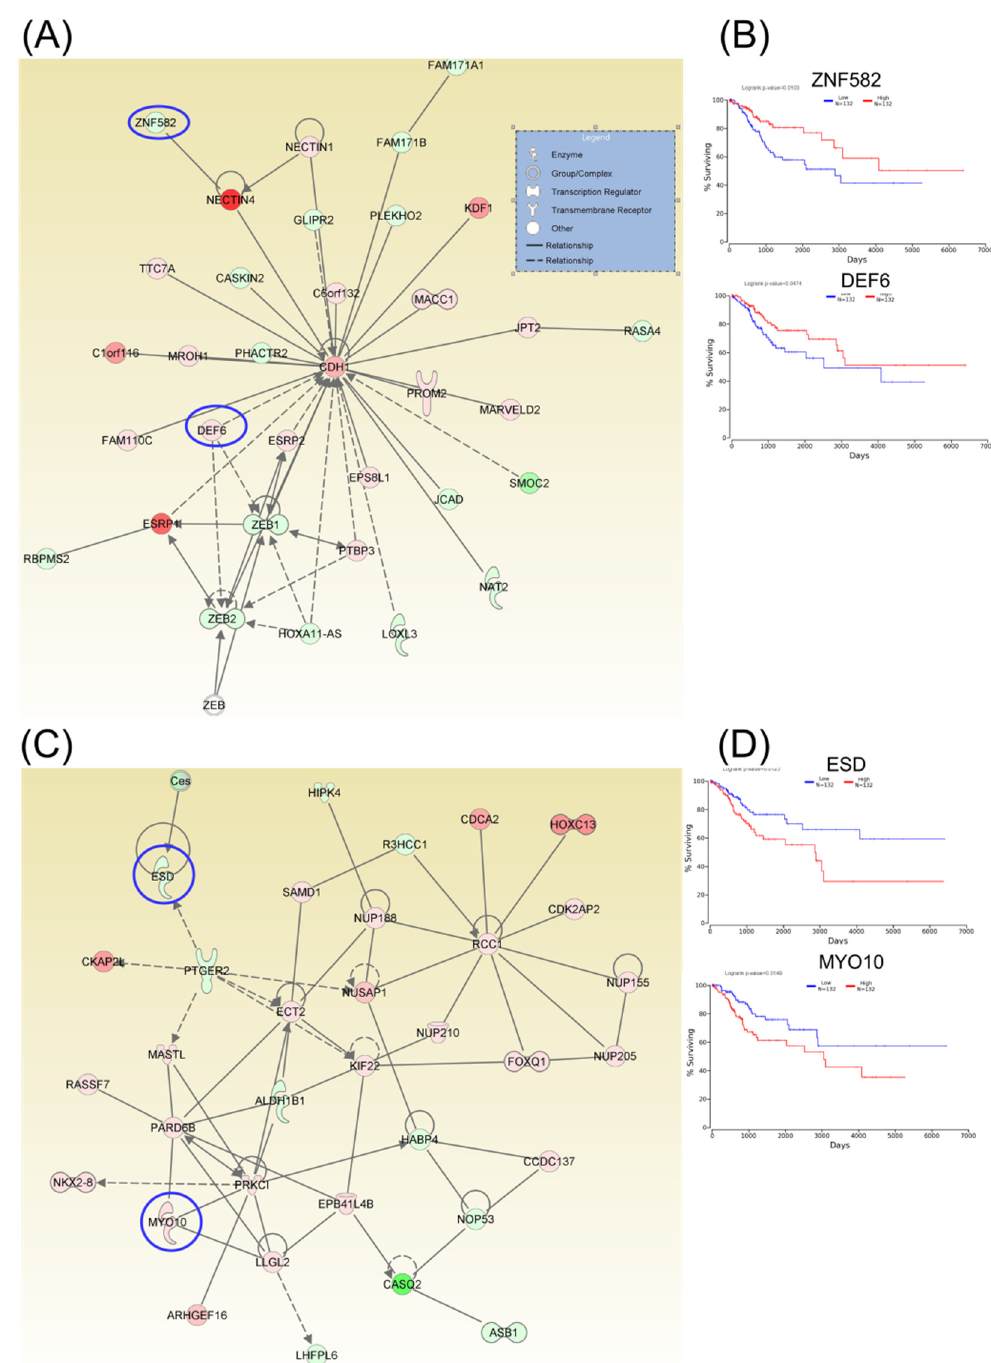
Figure 4. A signaling network analysis using IPA software for differentially expressed genes in CC. ( A ) Network 7: Cell-To-Cell Signaling and Interaction, Cellular Assembly and Organization, as well as Cellular Development. ( B ) Genes predicting overall survival in network 7. ( C ) Network 8: Cell-To-Cell Signaling and Interaction, Cellular Assembly and Organization, as well as Cellular Development. ( D ) Genes predicting overall survival in Network 8; red: overexpressed genes, green: downregulated genes, blue circles are for genes predicting overall survial rate in CC Furthermore, Kaplan–Meier plotter online tools were used to identify prognostic information related to gene networks of di ff erentially expressed genes involved in TP53 signaling (Figure 5). This revealed that four genes (DNA-PK, E2F1, BCL2, and PCNAR) correlated well with overall survival,